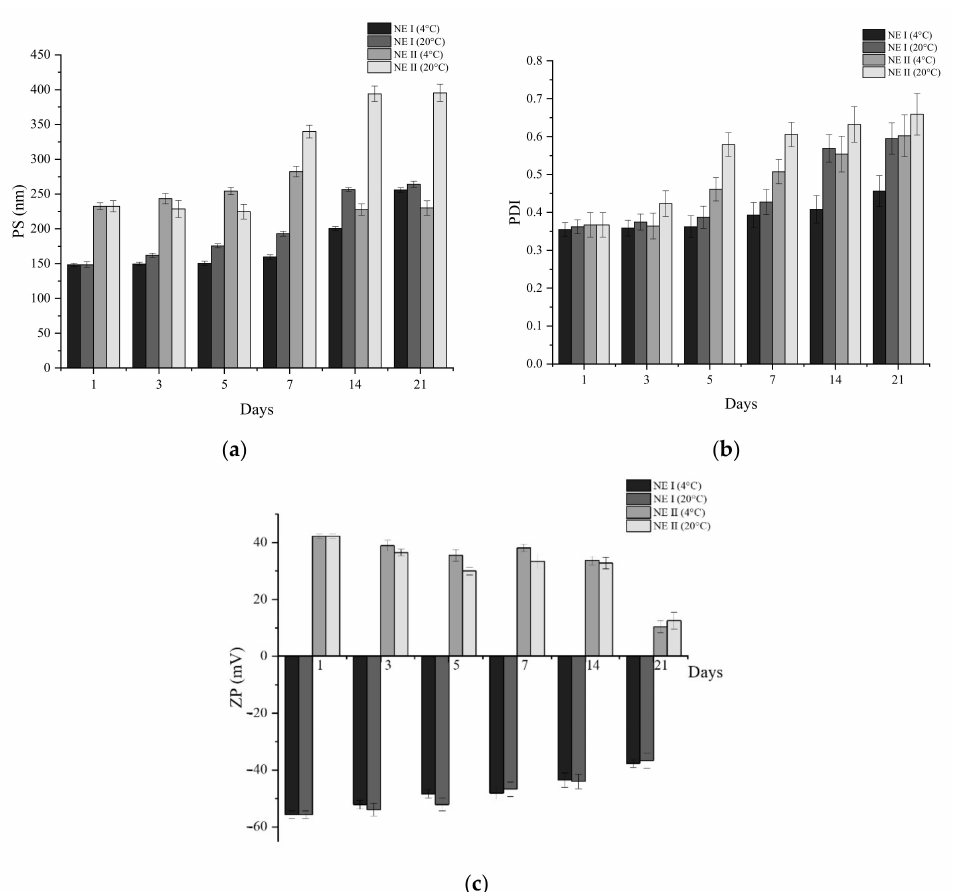
Figure 5. ( a ) Particle size (PS), ( b ) polydispersity (PDI), and ( c ) zeta potential (ZP) of loaded NE I and NE II, as a function of time for different storage